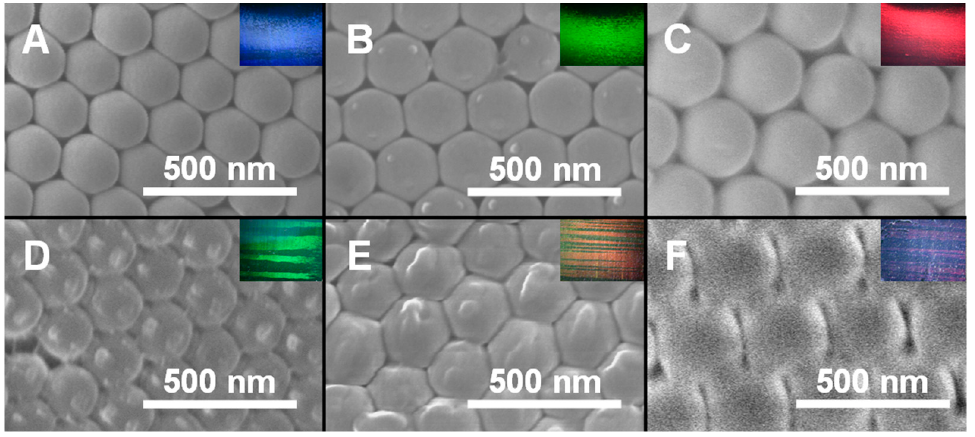
Figure 3. SEM photos of CPCs assembled PS nano-colloids with different diameters: ( A ) 186 nm, ( B ) 209 nm, ( C ) 252 nm; SEM photos of PVA infiltrated CPCs assembled PS nano-colloids with different diameters: ( D ) 186 nm, ( E ) 209 nm, ( F ) 252 nm. Inserts are the optical photos corresponding to the samples.